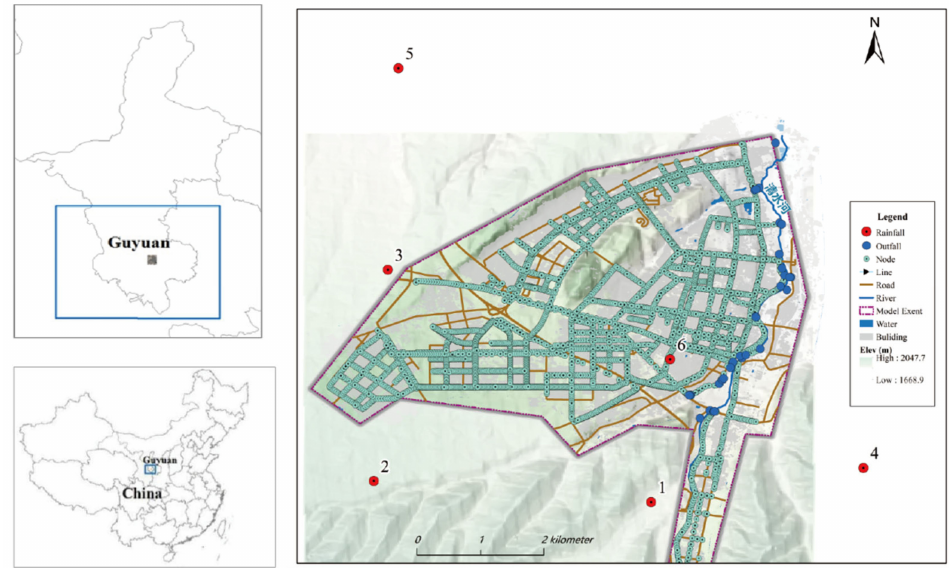
Figure 2. The specific location and range of the study